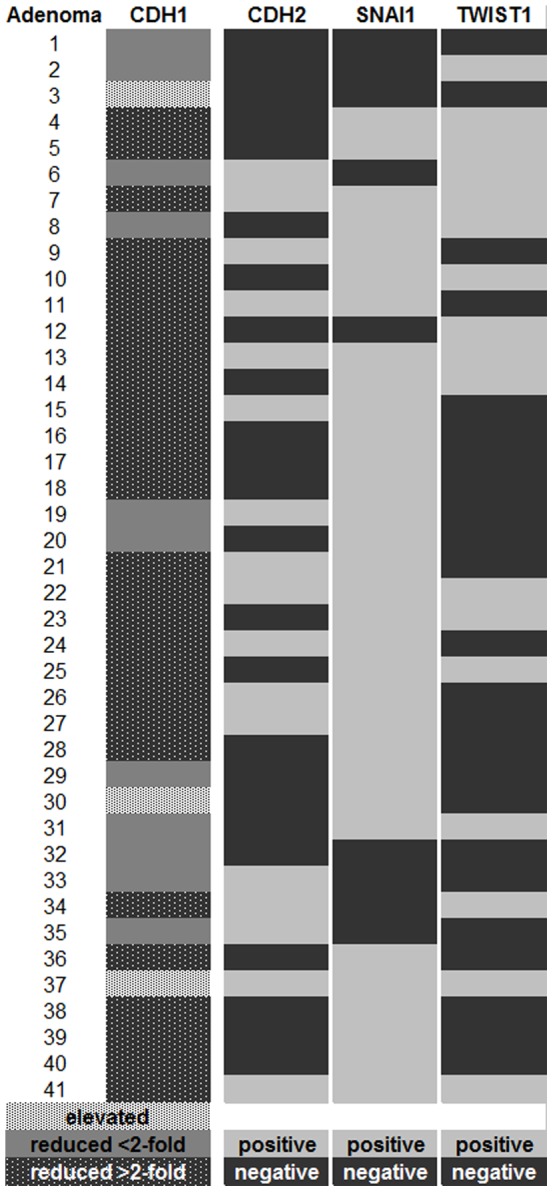
Expression profile of colorectal adenomas in the qRT-PCR.CDH1: up- and downregulation compared to normal colonic mucosa.